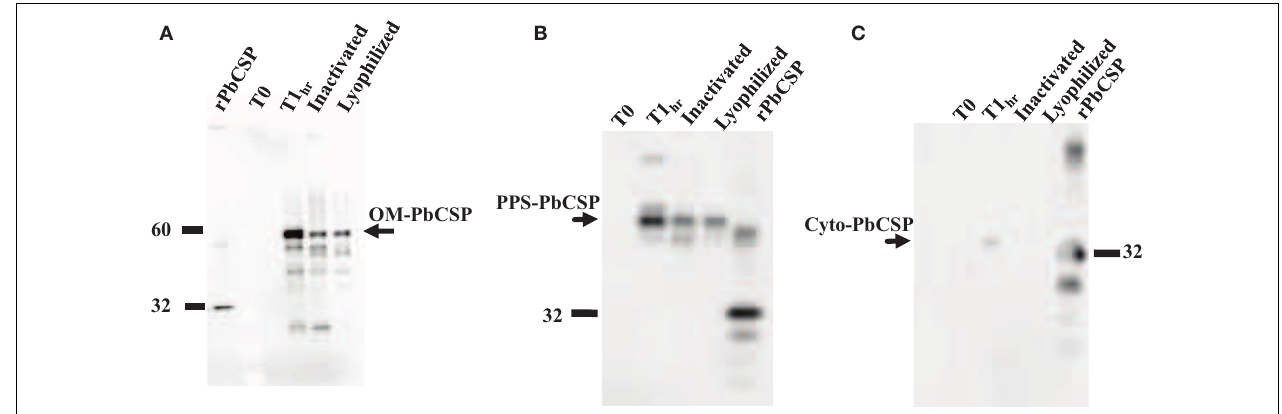
FIGURE 2 |Western blot expression profiles of GeMI-Vax Pb CSP from different sub-cellular localizations . (A) Targeting Pb CSP to the outer membrane, OM- Pb CSP. Lanes: 5ng r Pb CSP; un-induced cells (T0), 1h post IPTG induction (T1h), post ColE3 inactivation, post lyophilization; (B) Targeting Pb CSP to the periplasmic space, PPS- Pb CSP. Lanes: un-induced cells (T0), 1h